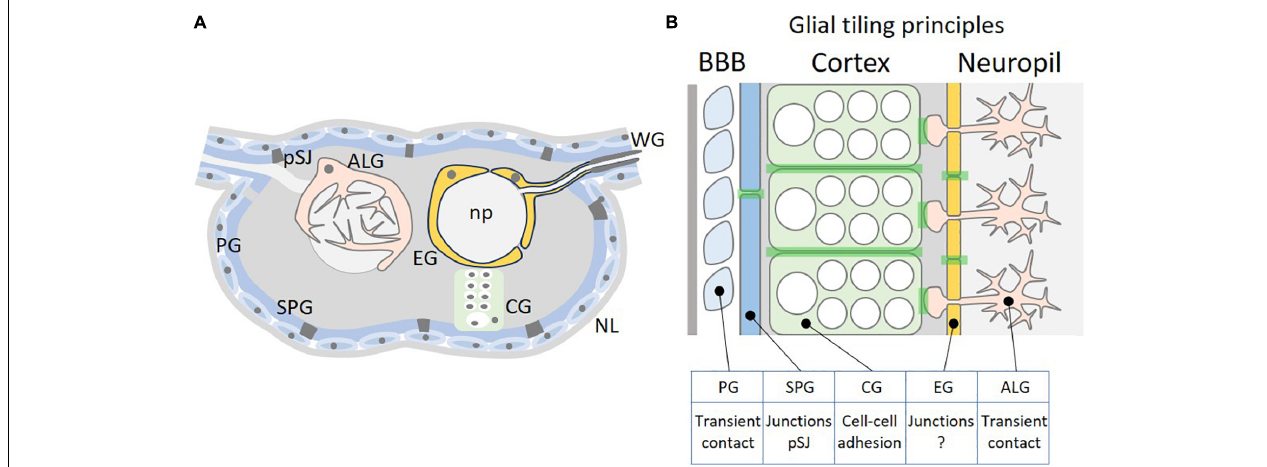
FIGURE 1 | Tiling of glial cells of the Drosophila CNS. (A) Schematic cross-section through the Drosophila CNS. The outer surface of the nervous system is covered by a thick extracellular matrix called neural lamella (NL). Below are the perineurial and subperineurial glial cells (PG and SPG) that establish the blood-brain barrier by forming pleated septate junctions (pSJ). Neural stem cells and neuronal cell bodies are covered by the cortex glia (CG). The inner neuropil (np) is covered by astrocyte-like glial and ensheathing glial cells. For a schematic view of the adult CNS please see Kremer et al. (2017). (B) Possible tiling principles among different glial cell classes. PGs have only transient contact, whereas SPGs are polarized cells that establish extensive pleated septate junctions. CGs interact along a large cellular interface and tiling likely involves adhesion. EGs are polarized cells and form a barrier similar as the SPGs. However, no specific cell-cell junctions have been clearly documented between EGs. ALGs tile the neuropil without forming extensive cell-cell contacts and therefore tiling is likely to require transient contacts, too. The light green shading indicates cell-cell interaction zones where tiling principles are